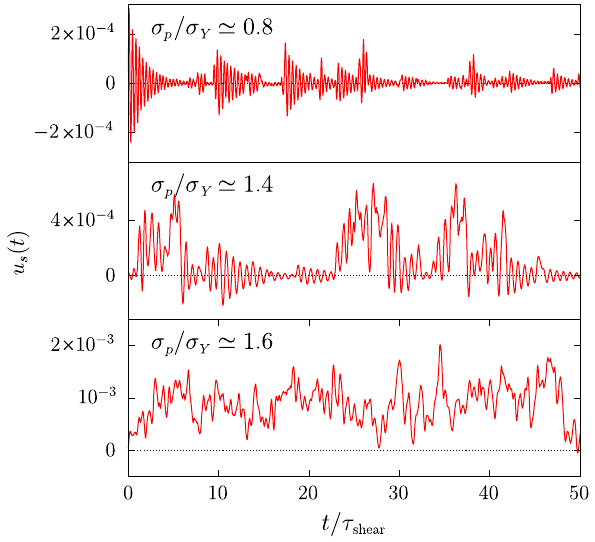
FIG. 3. Time sequence for the projection of the velocity field onto the viscous solution u s ð t Þ [see Eq. (3)] for Kolmogorov flow simulations at different peak-stress σ p values. Time is rescaled by ¼ S − 1 as derived from the stress-dependent shear time τ shear Eq. (3). For small forcing, σ p = σ Y ≃ 0 . 8 , the system responds elastically and dissipates mainly through elastic waves visible from the periodic oscillations around 0. At σ p = σ Y ≃ 1 . 4 , the system is at the middle point between the two branches (see Fig. 2), and it intermittently switches between an elastic response = σ ≃ 1 . 6 , and a plastic flowing regime for which u s ð t Þ > 0 . At σ p Y the system is plastically flowing